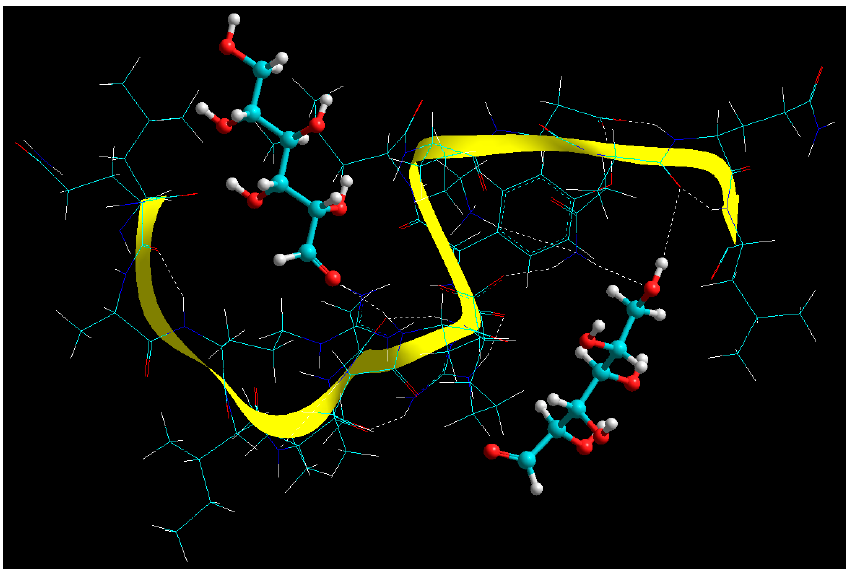
Figure 4. Visualization of geometrical preferences and functional interactions between BSA (stick rendering) in complexation with the glucose molecules (ball-and-tube rendering) after molecular mechanics simulations in vacuum. Colour codes: C (cyan), O (red), N (blue) and H (white).